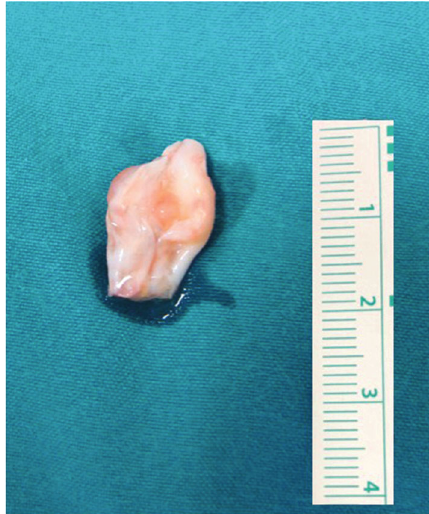
Figure 2: Intraoperative specimen of the excised tumor including a portion of the EDC tendon